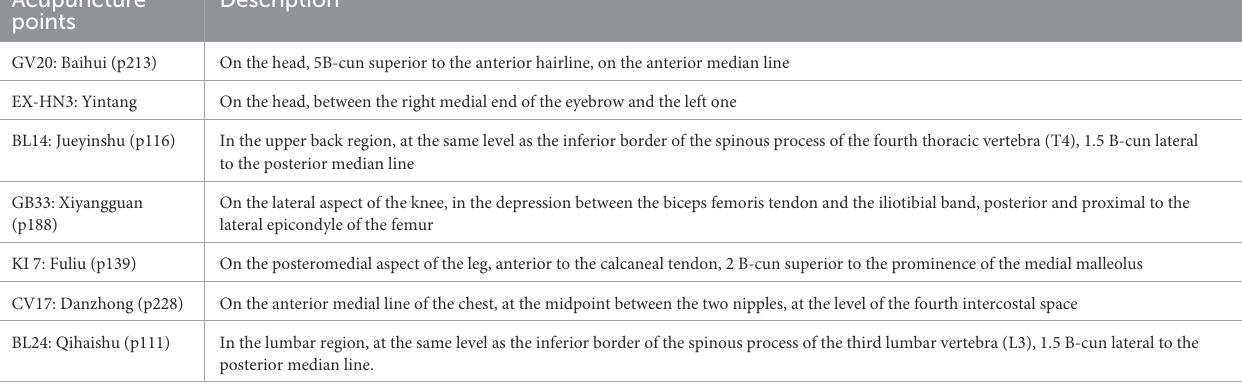
TABLE 2 Framework of the acupuncture point